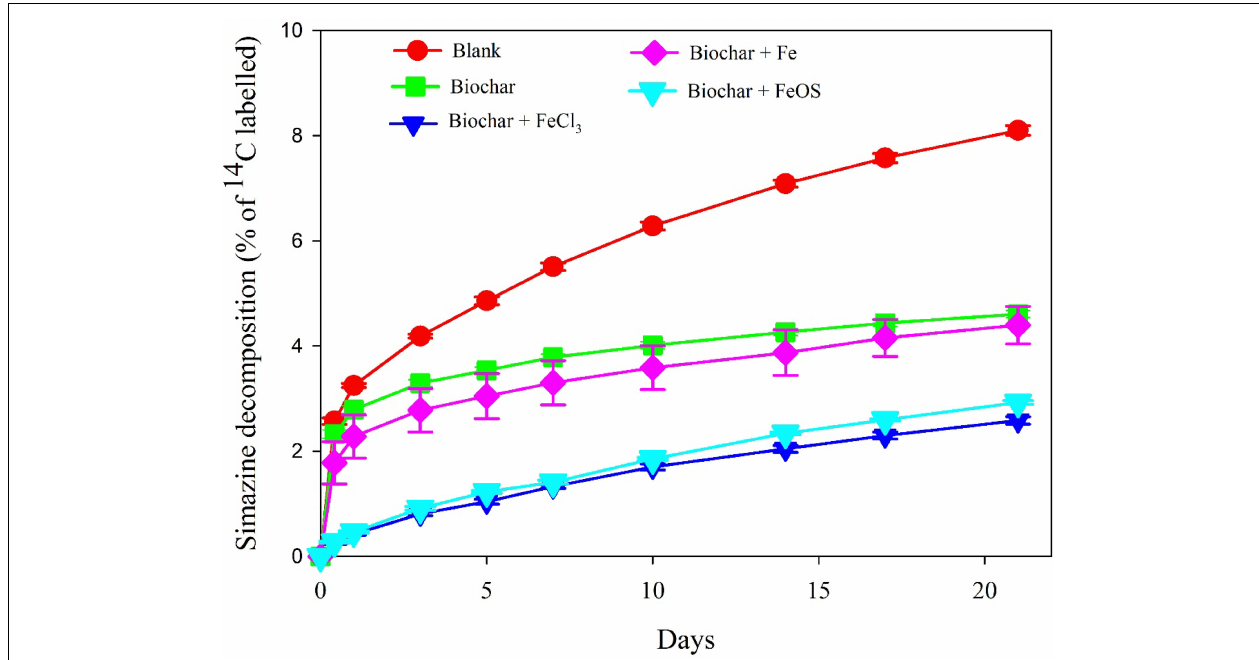
FIGURE 6 | The simazine decomposition in the soil amended with biochar or iron modified